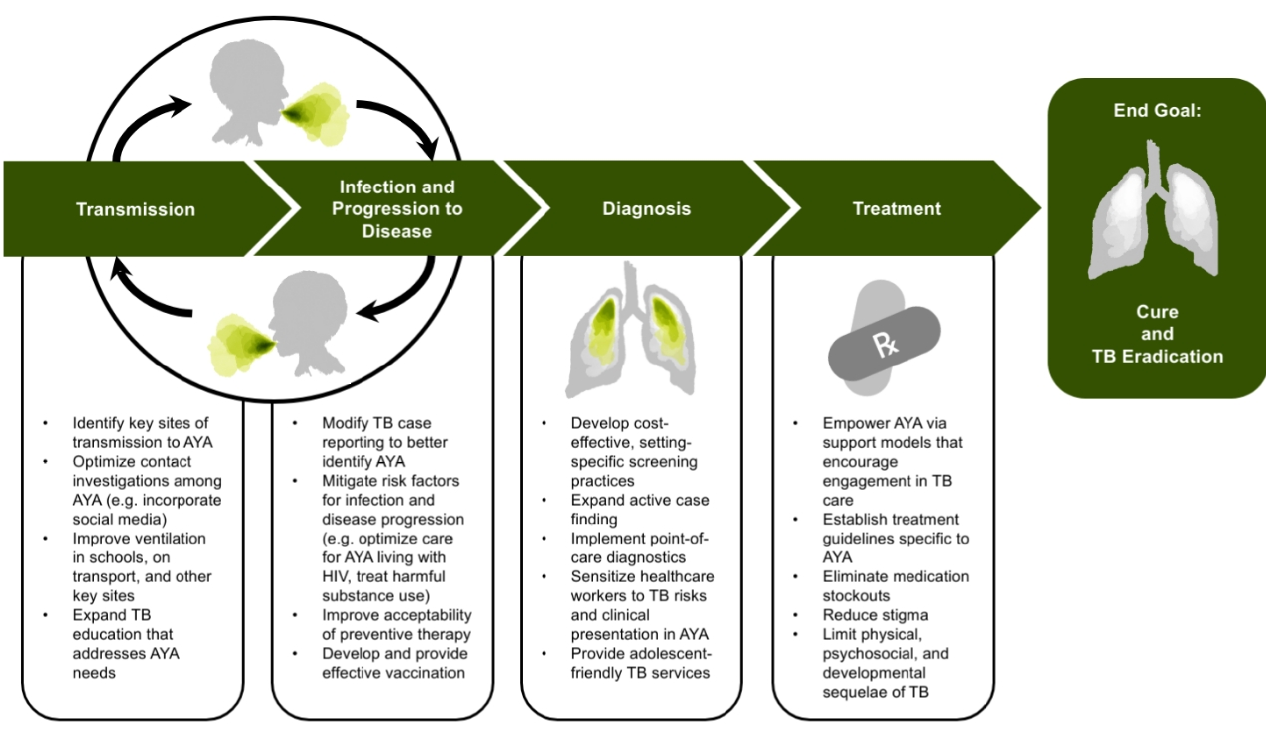
Figure 2. Public Health Priorities and Areas for Further Research and Implementation to Address TB among Adolescents and Young Adults.